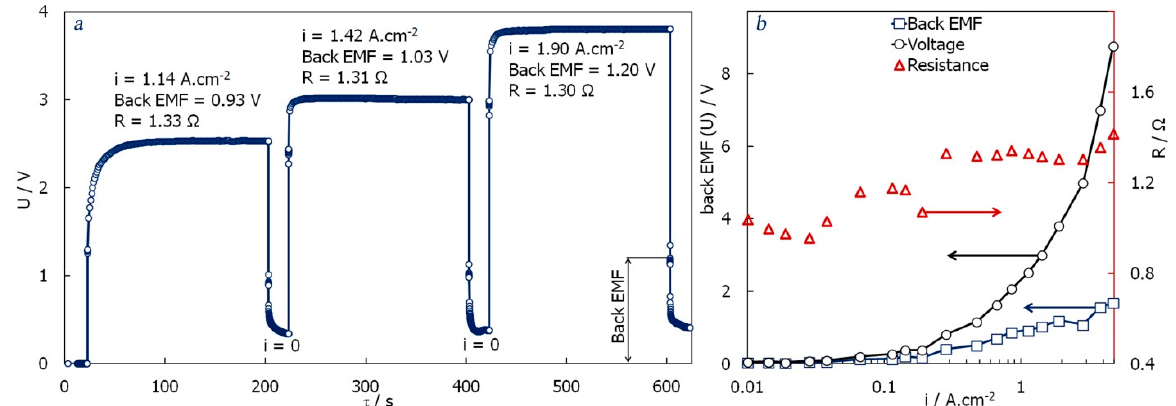
Figure 5. Results obtained in the multiple-capillary cell with the 64LiF–36AlF 3 (molar ratio) melt at 800 ◦ C: ( a )—typical potential vs. time dependence during galvanostatic polarization with current interrupts, ( b )—quasi-stationary resistance, voltage, and back EMF as a function of applied current